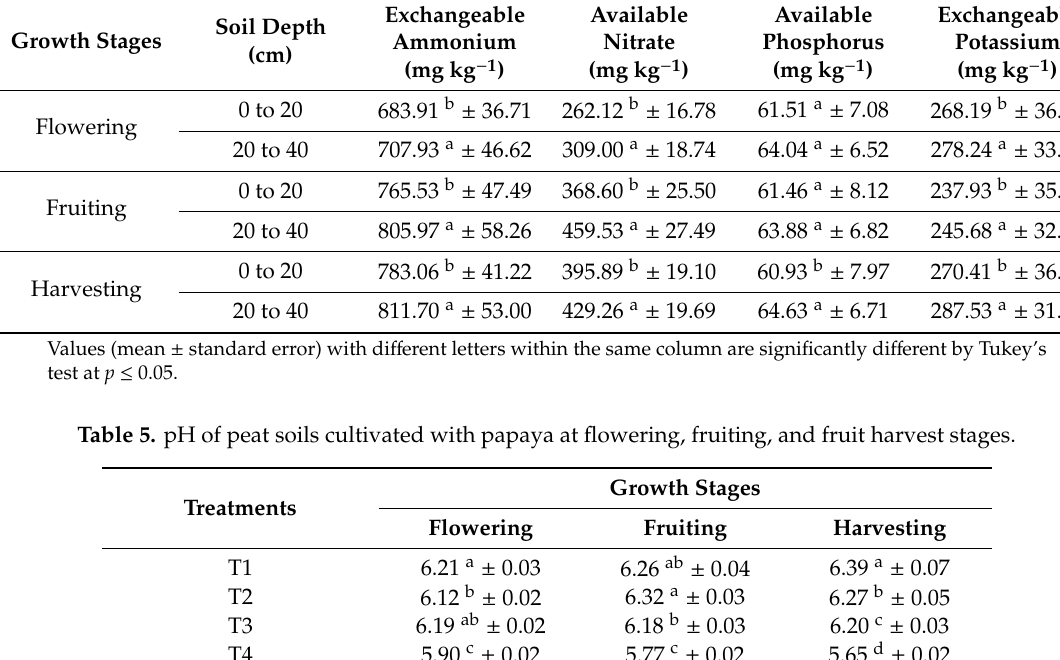
Table 4. Mean exchangeable ammonium, available nitrate, available phosphorus, and exchangeable potassium over all treatments (T1 to T5 and control) in a peat soil at di ff erent soil depths and growth stages of papaya plants treated with di ff erent amounts of CZ and NPK fertilizer. Growth Stages